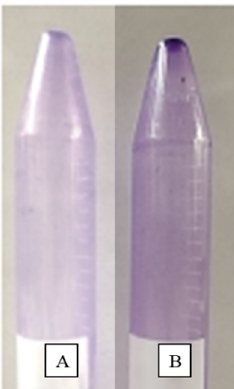
Figure 13. Biofilm inhibition analysis. ( A ) Positive control containing S. aureus. ( B ) S. aureus treated with CI-TiO 2 -MSs.